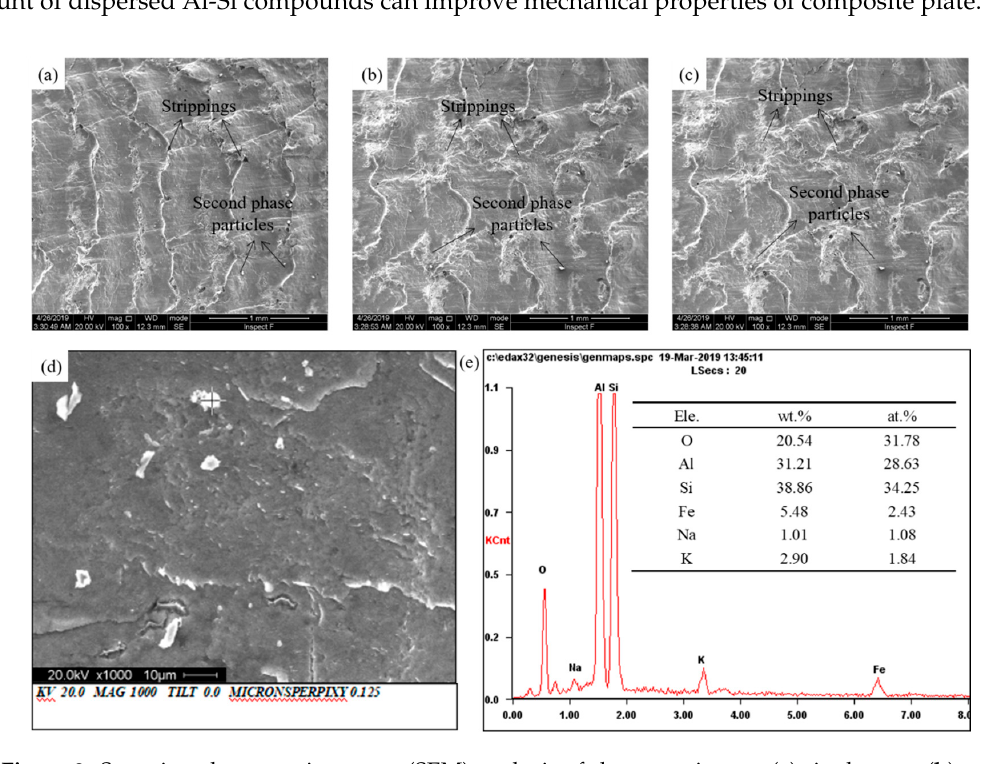
Figure 9. Scanning electron microscope (SEM) analysis of shear specimens: ( a ) single pass; ( b ) two passes; ( c ) three passes; ( d ) and ( e ) SEM and Energy Dispersive Spectroscopy (EDS) analysis of second phase particles.